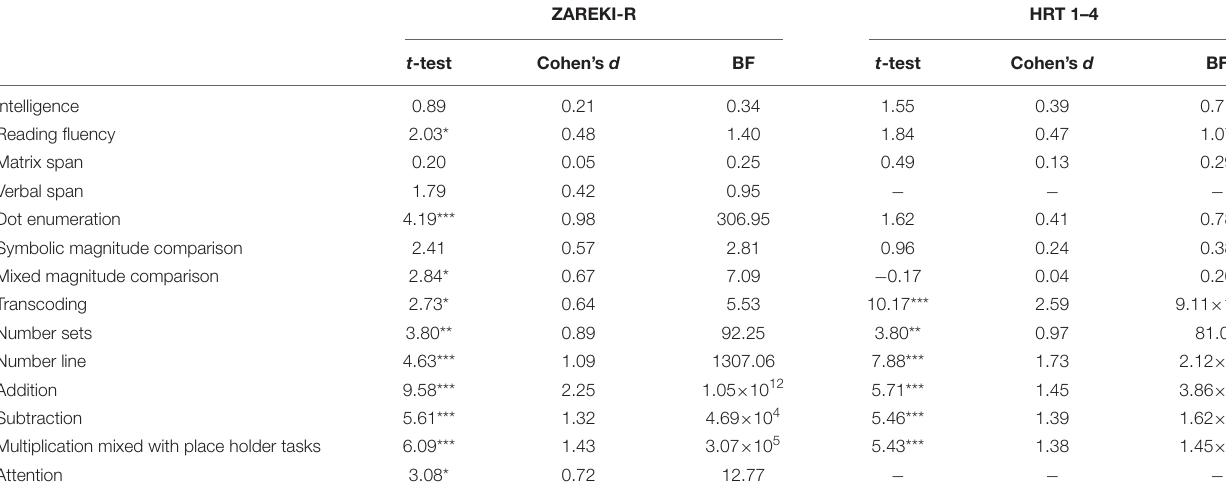
TABLE 6 | Subgroup mean comparison—clustered by